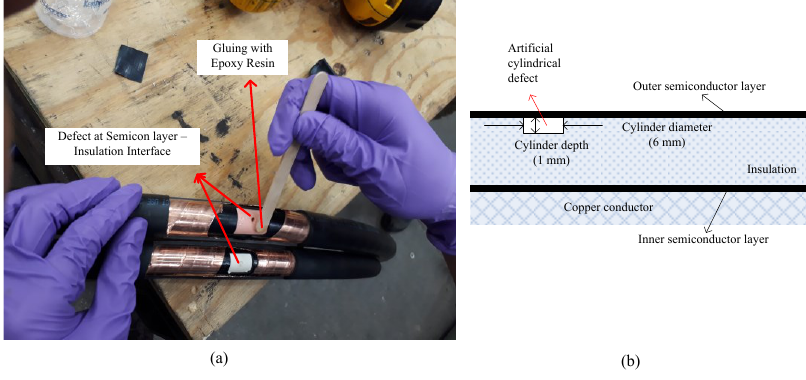
Figure 4. Preparation of test cables with artificial defects at outer semicon layer and dielectric interface ( a ) snapshot of actual samples; ( b ) side view depicting defect location and dimensions.